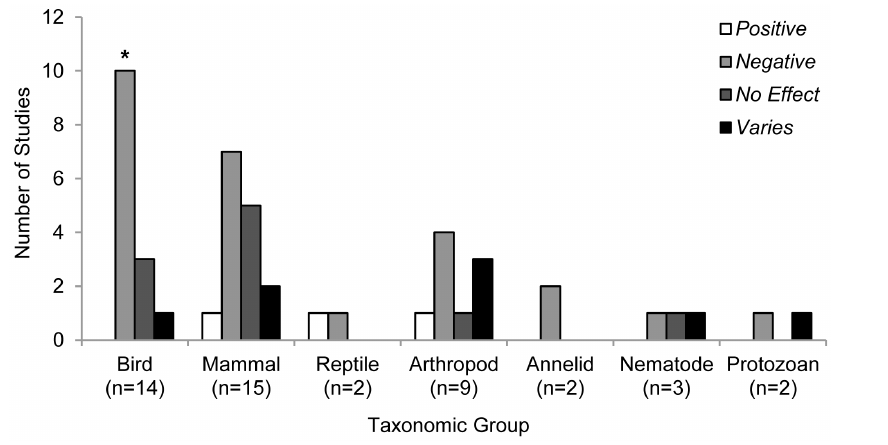
Figure 5. Number of studies (n=41) investigating the effects of winter recreation on seven different taxonomic groups. **P , 0.01 indicates a significant difference between the number of positive and negative effects